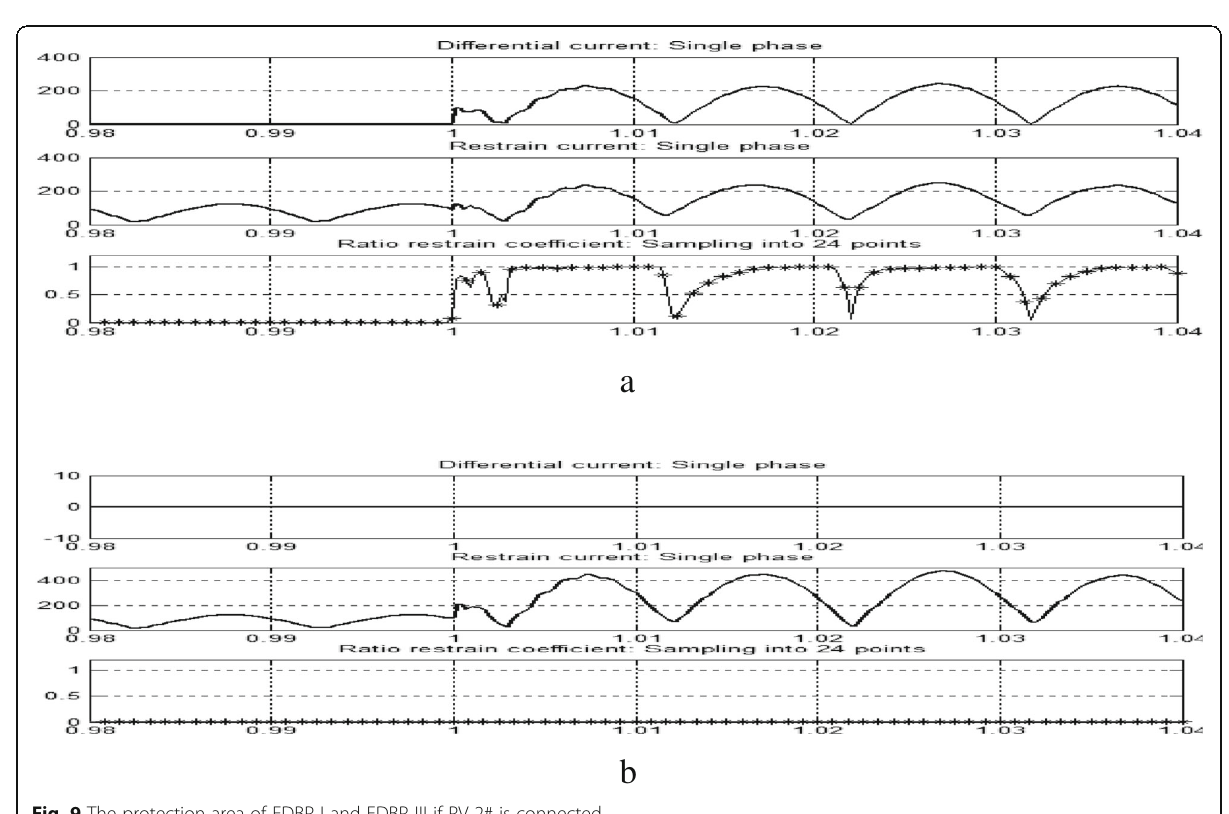
Fig. 9 The protection area of EDBP I and EDBP III if PV 2# is